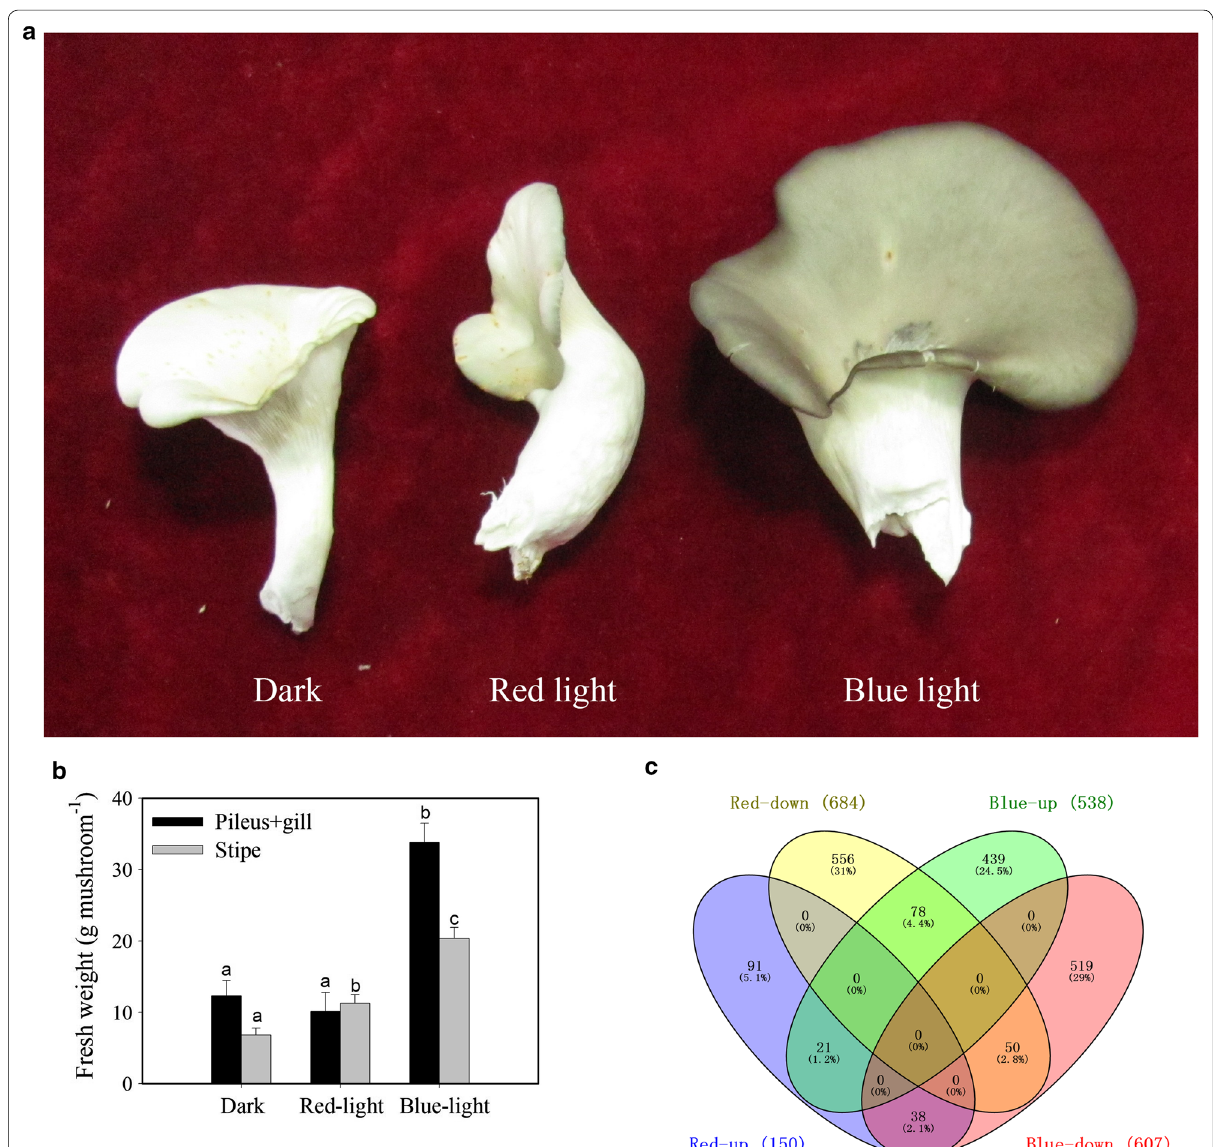
Fig. 1 Effects of blue light and red light on growth ( a , b ) and gene expression ( c ) of P. ostreatus . Values of fresh weight are expressed as means ( standard deviation, SD) of 10 mushrooms. Means followed by different letters among treatments in the same organ are significantly different, ± according to t test ( P < 0.05).Venn diagram showing the number of DEGs in the pileus between the red-light or blue-light treatment and dark treatment. DEGs were defined as genes with fold change > 2 and adjusted P